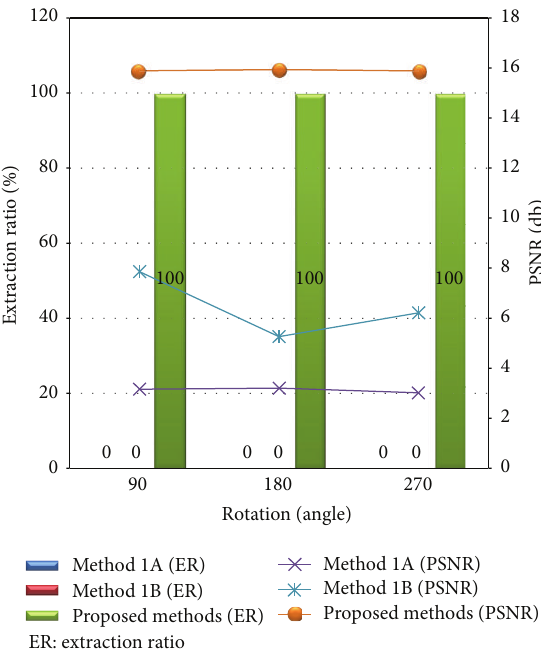
Figure 15: Extraction ratio and PSNR in each rotation.